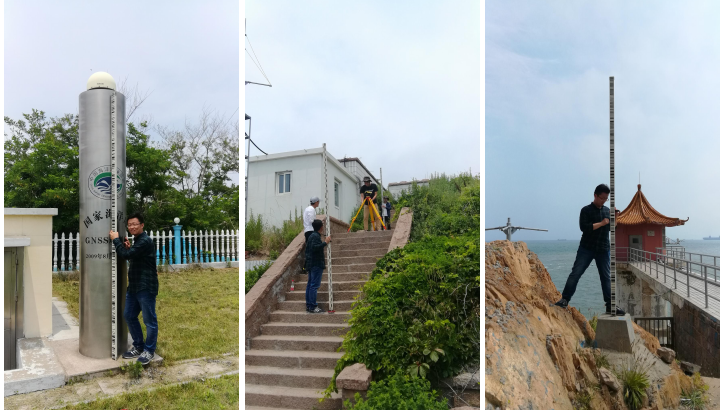
Figure 6. The spirit leveling work between the GNSS permanent station and the tide gauge at station XMD. The left-hand photo is of the permanent GNSS station; the middle photo shows the leveling work between the GNSS and the benchmark of the tide gauge; and the right-hand photo shows the benchmark of the tide gauge and the tide